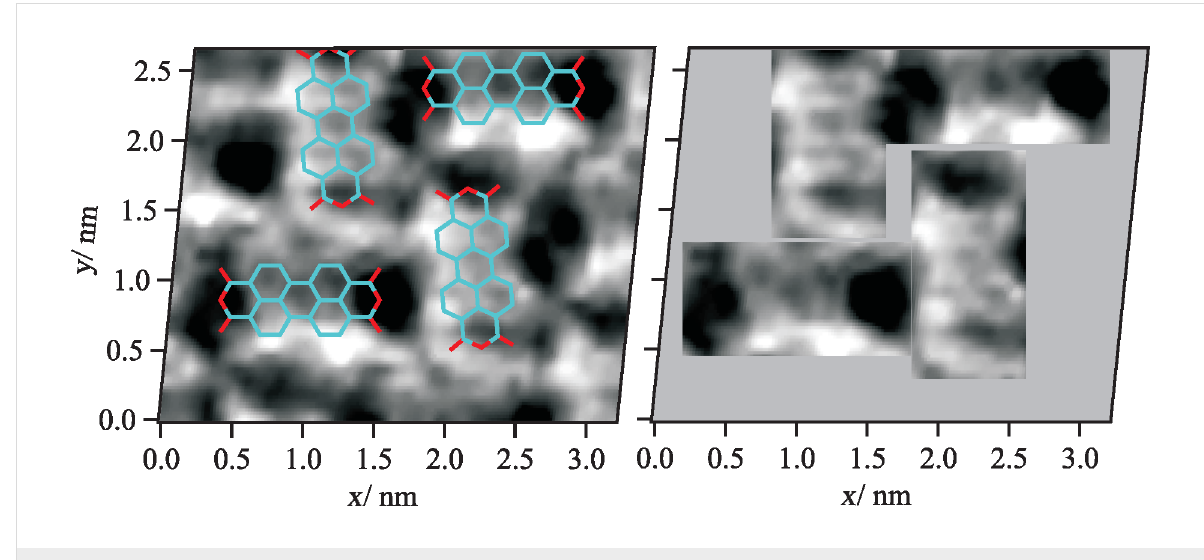
Figure 2: Horizontal cut through the 3D field of the vertical tip–sample forces at a distance of z = 0.60 nm (left). Dark features correspond to areas of enhanced attractive forces (for a quantitative analysis: see below in Figure 3 and Figure 4). The lateral drift was corrected in the images resulting in a distortion of the originally rectangular surface area. The images were linearly interpolated with a factor of 4 to enhance the visibility. Intramolecular structures can be seen in both the raw data images and the interpolated images. The characteristic shape of the perylene core consisting of five carbon rings can be identified, which allows an exact determination of the molecule positions in the 3D force spectroscopy measurement. The areas that can be assigned to PTCDA molecules are shown separately (right).